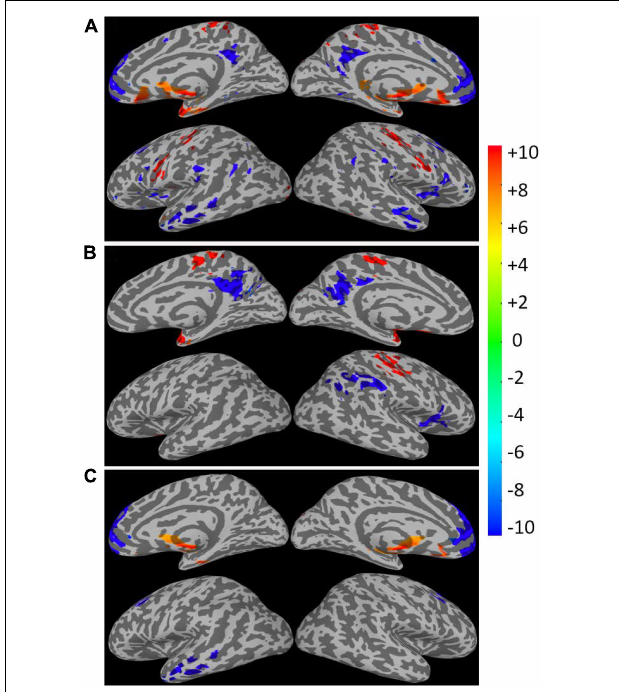
FIGURE 6 | Brain regions with significant correlation ( p < 0.05, corrected) between the connectivity strength metrics and the subject’s age. The results for the CDI (A) , CDI N (B) , and CDI P (C) are depicted separately. The Color bar shows the t -score